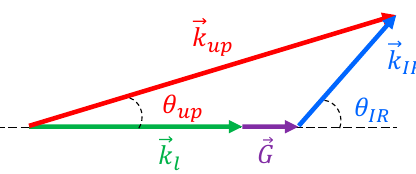
Figure 2. Sum ‐ frequency mixing (SFM) image up ‐ conversion process. Figure 2. Sum-frequency mixing (SFM) image up-conversion